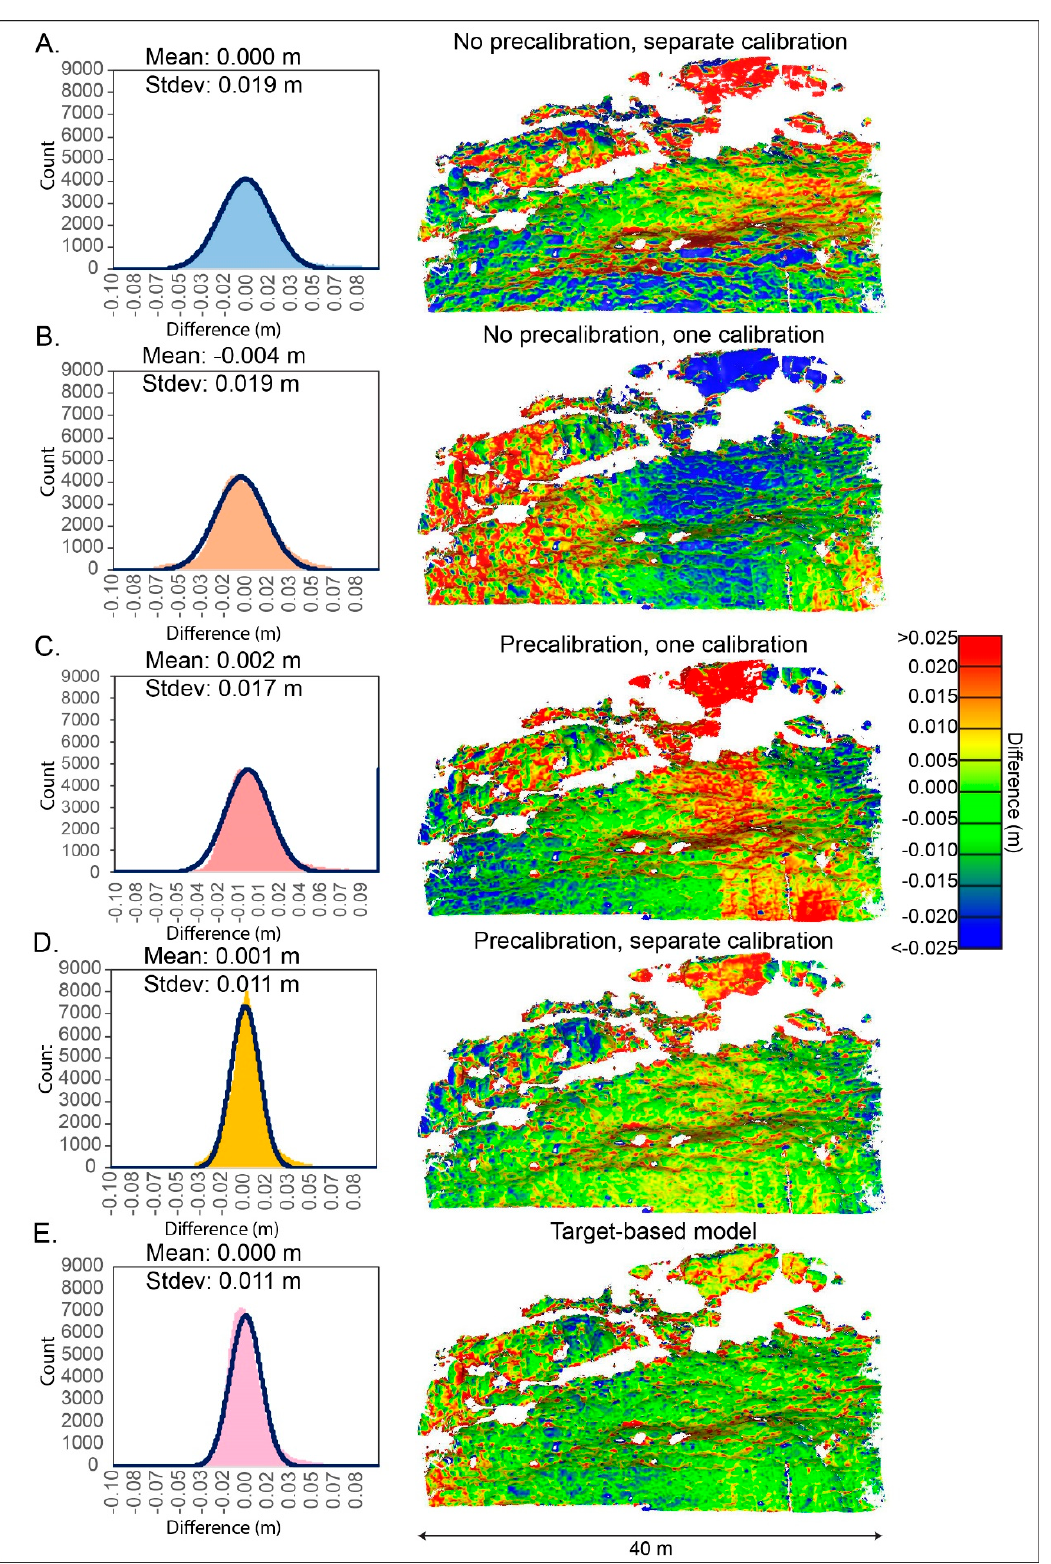
Figure 8. Quantitative and qualitative assessment of SfM model accuracy by comparing with TLS reference model.